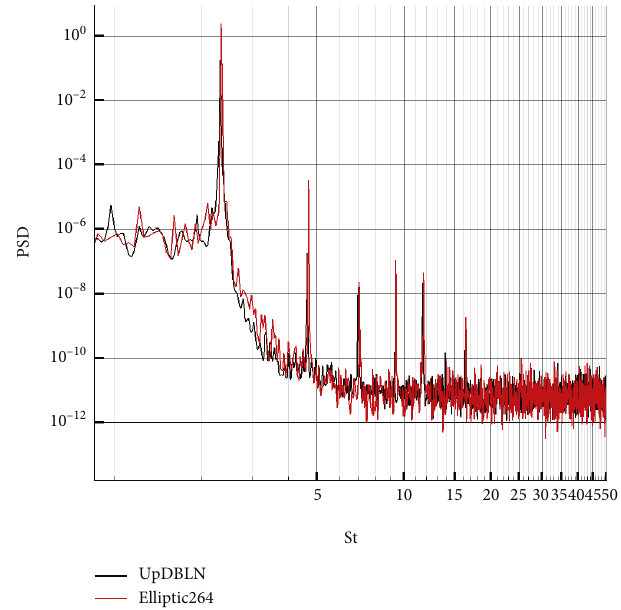
Figure 21: PSD of UpDBLN and Elliptic264 ( Re = 0 : 8 E 6 , α = 0 ° ).